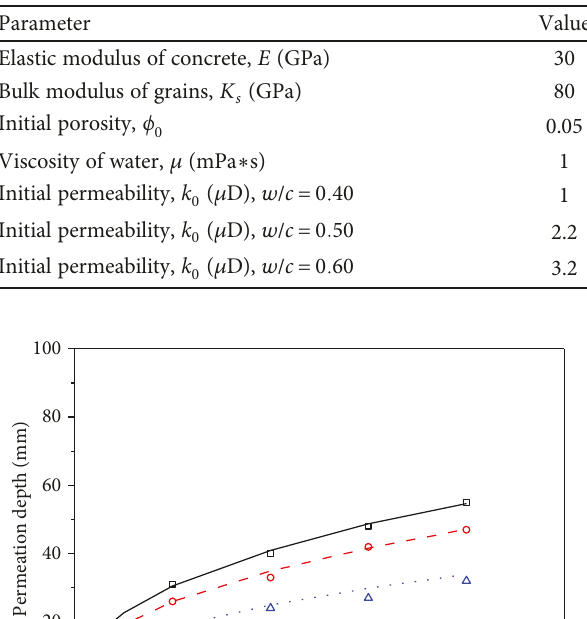
Table 2: Computational parameters of concrete.